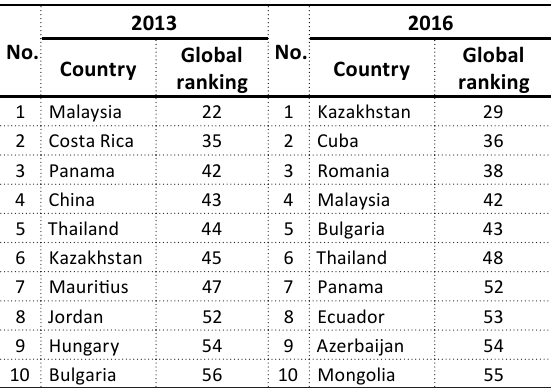
Table 3. Top 10 upper-middle income countries according to World Economic Forum (WEF) Human Capital Index